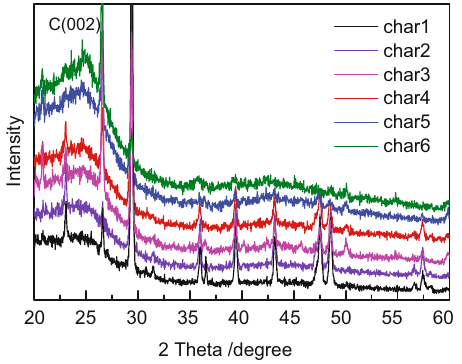
Figure 4: XRD spectrums of di ff erent semi - cokes.